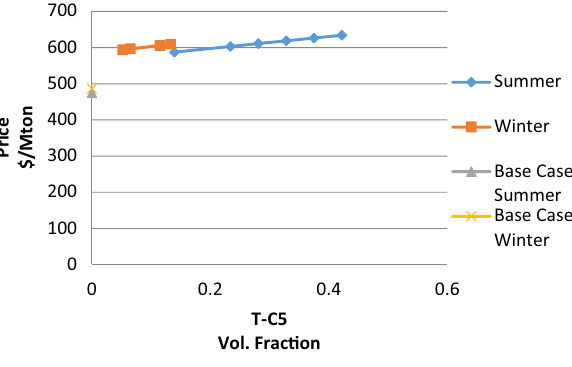
Fig. 41 Effect of adding i-C5, 2,2DMP and 20 vol% DME on LPG propane content